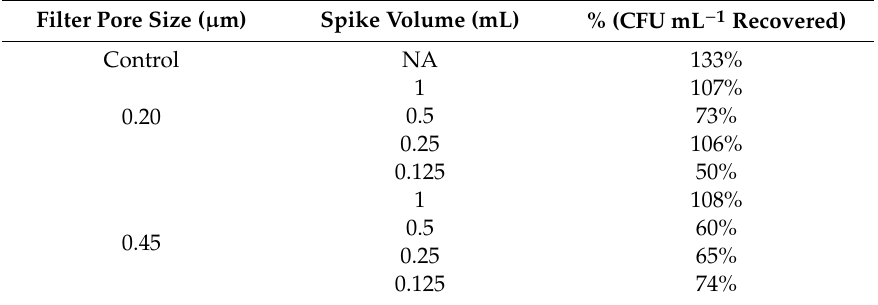
Table 2. Recovery efficiency of E.coli DSMZ 1576 from a spiked 5 L sample using 0.20 and 0.45 µm pore size filters passed through the InnovaPrep © concentrating pipette. The recovery efficiency was determined by the extent to which the optical density of the spike and that of the eluent matched. Filter Pore Size ( µ m)